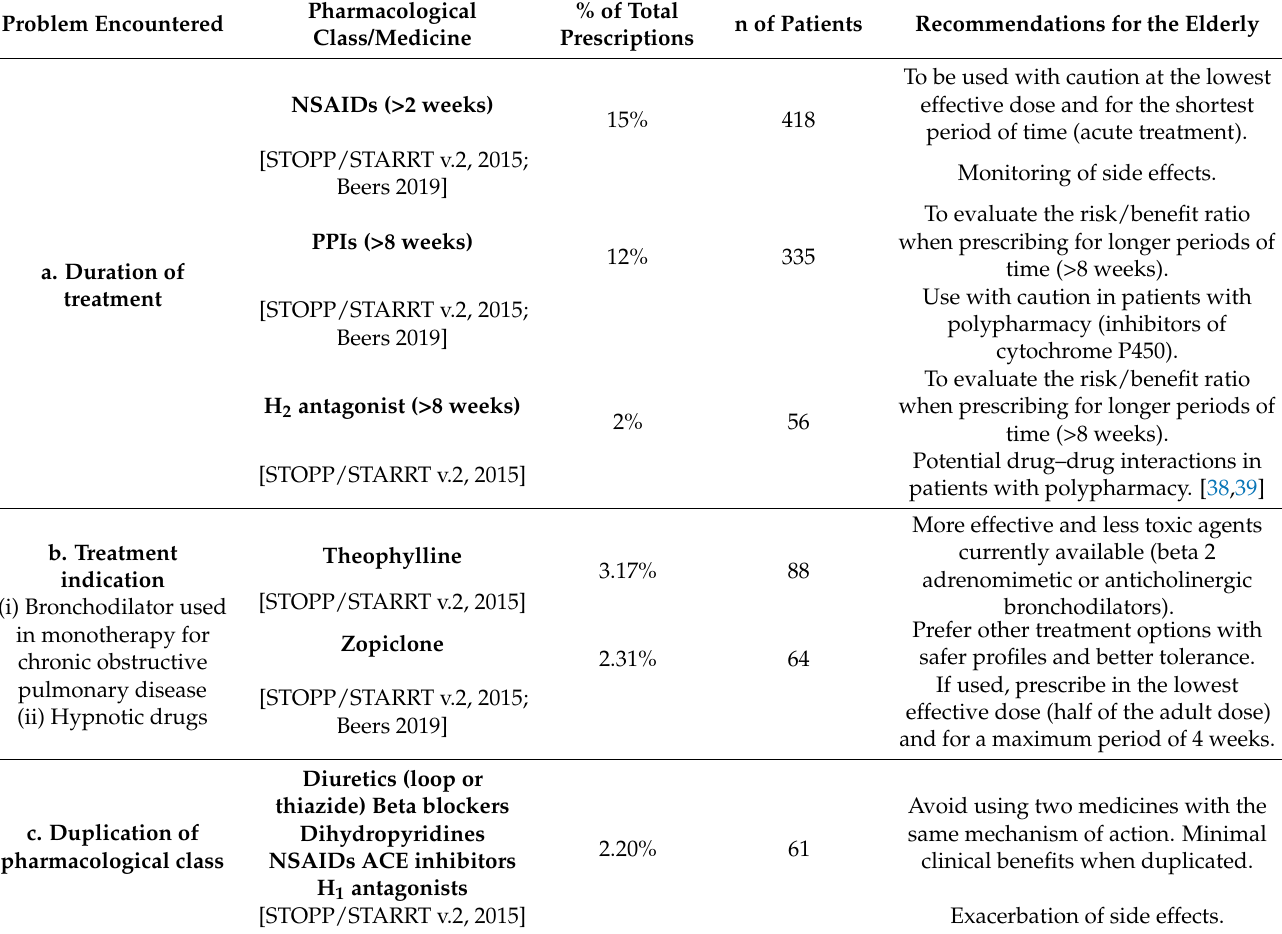
Table 3. Overuse of medicines according to STOPP/START v.2, 2015 and Beers 2019 Criteria [26,27].